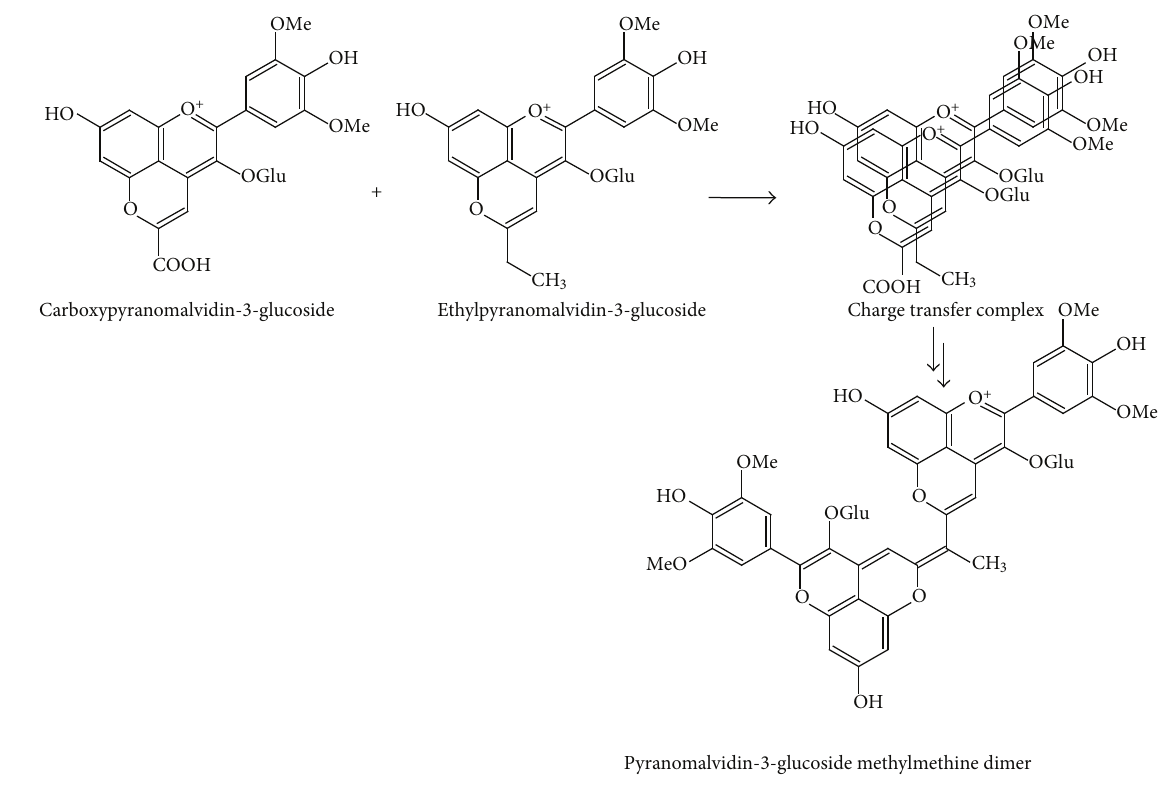
F 14: Proposed mechanism for the formation of pyranomalvidin-3- O -glucoside methylmethine dimer